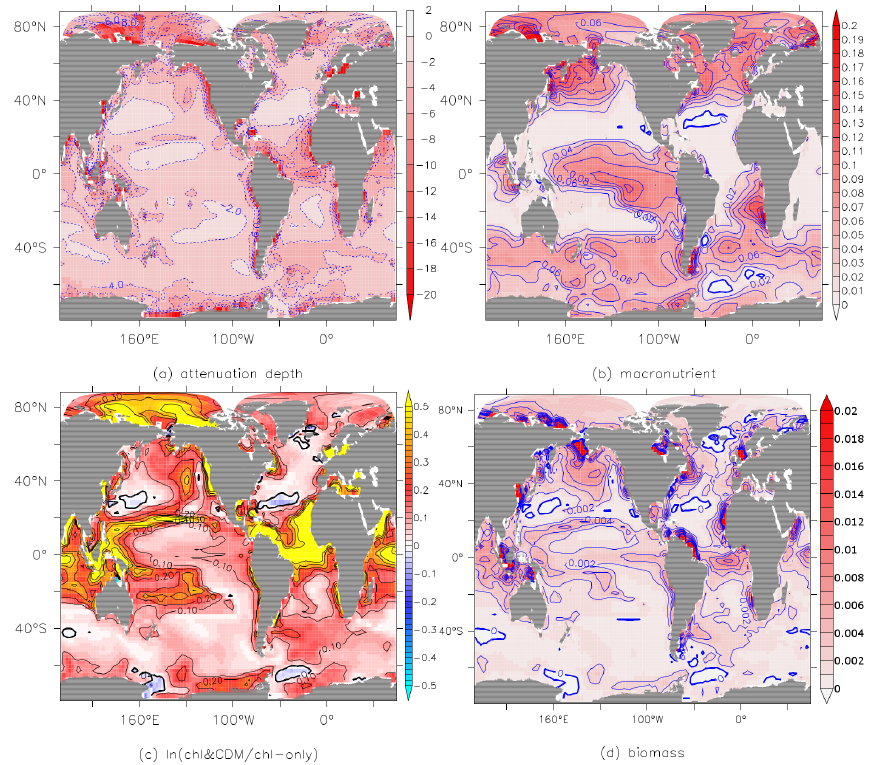
Figure 9. Difference (a) attenuation depth in m, (b) surface macronutrient concentration in µM, (c) surface chlorophyll concentration and (d) surface biomass concentration in gCm − 3 ; chl&CDM minus chl-only. Surface values represent the average over the top 10m. Panel (c) shows natural log ratio of chlorophyll concentration from the chl&CDM run over chl-only run, so positive values indicate an increase in chlorophyll in the chl&CDM run.